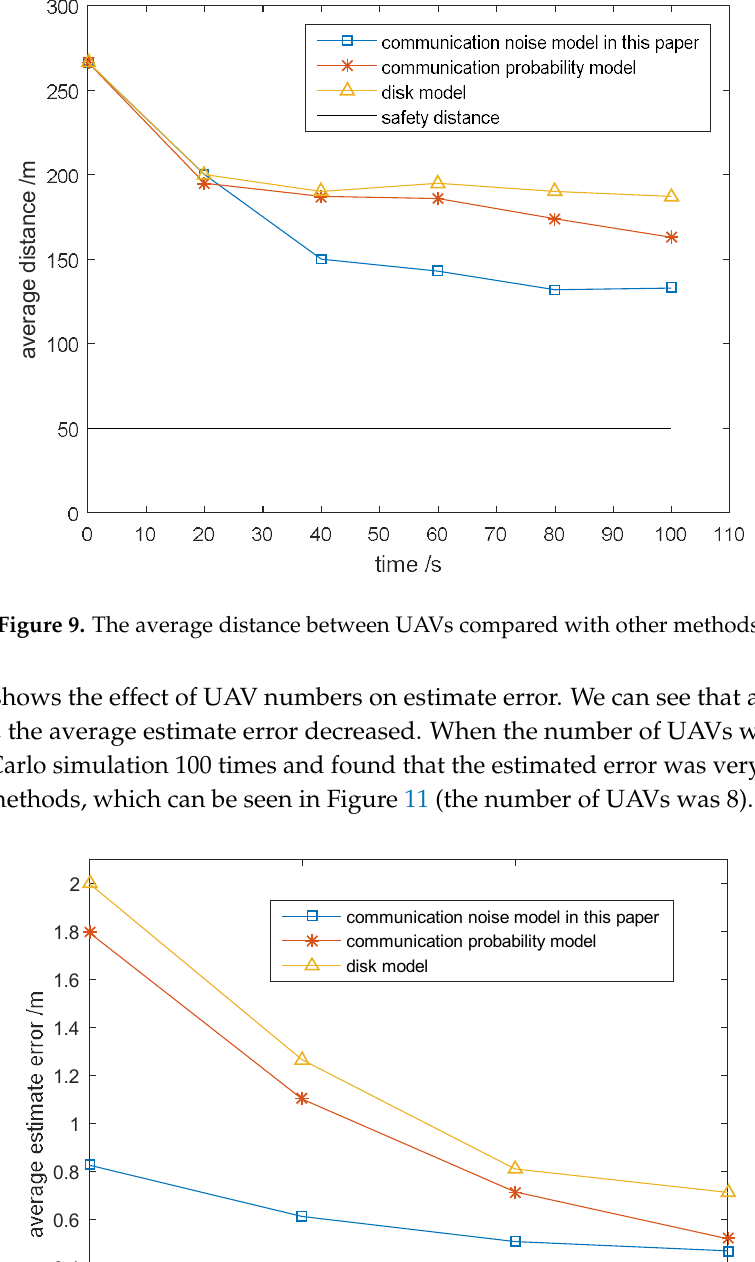
Figure 10. The impact of number of UAVs on average estimate error.